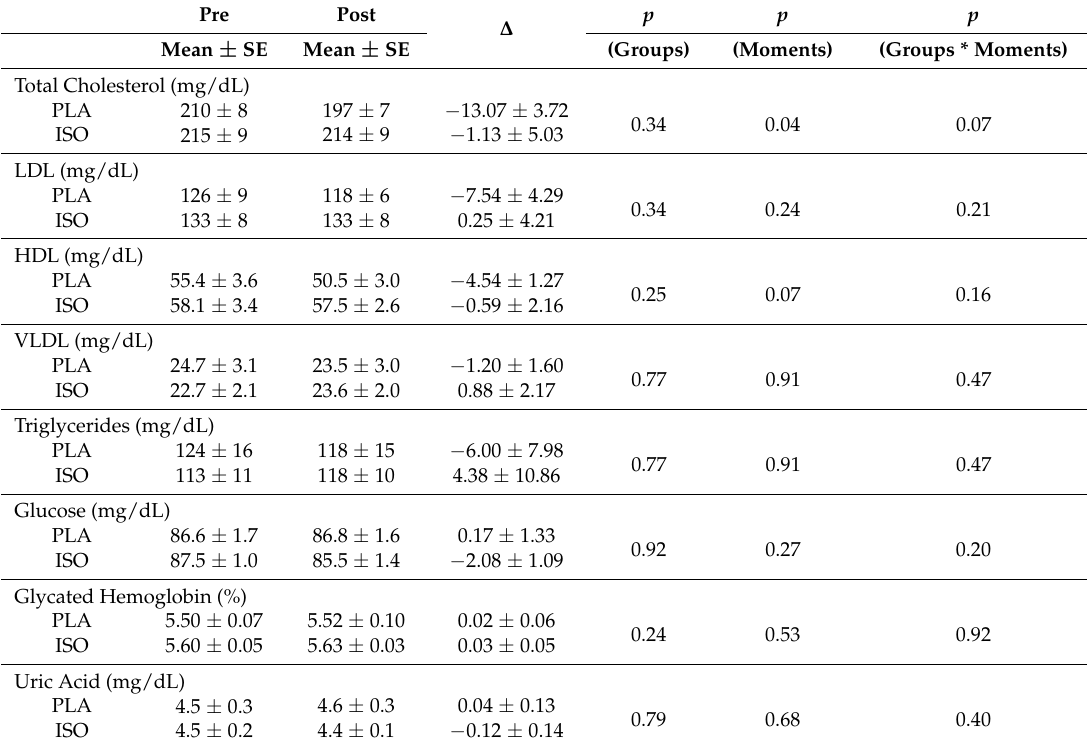
Table 1. Comparison of lipid profile, glucose, glycated hemoglobin and uric acid between the pre- and post-interventionin the placebo (PLA) and isoflavone (ISO) groups. Pre Post ∆ p p p Mean ± SE Mean ± SE (Groups) (Moments) (Groups * Moments) Total Cholesterol (mg/dL) PLA 210 ± 8 197 ±